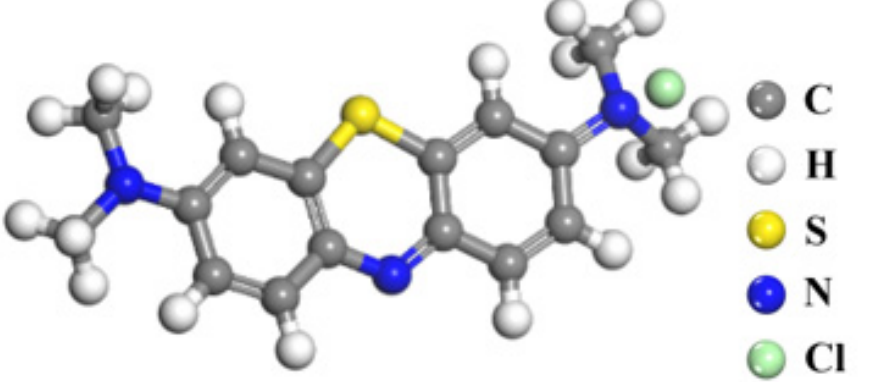
Figure 2. Molecular model of MB.